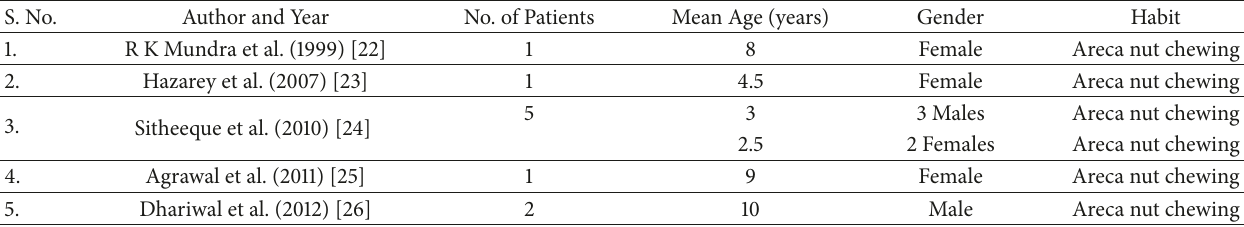
Table 1: Characteristics of studies included in the systematic